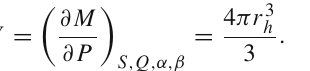
. So only large c